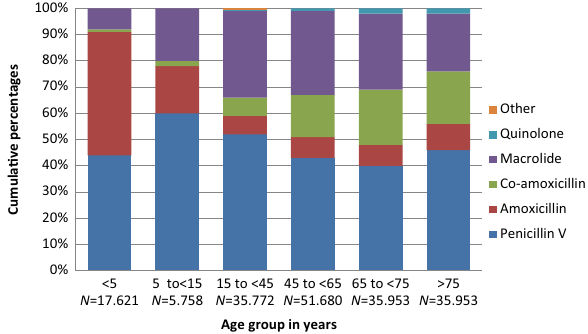
Fig. 5 Pneumonia. Prescribing pattern by age group ( N =